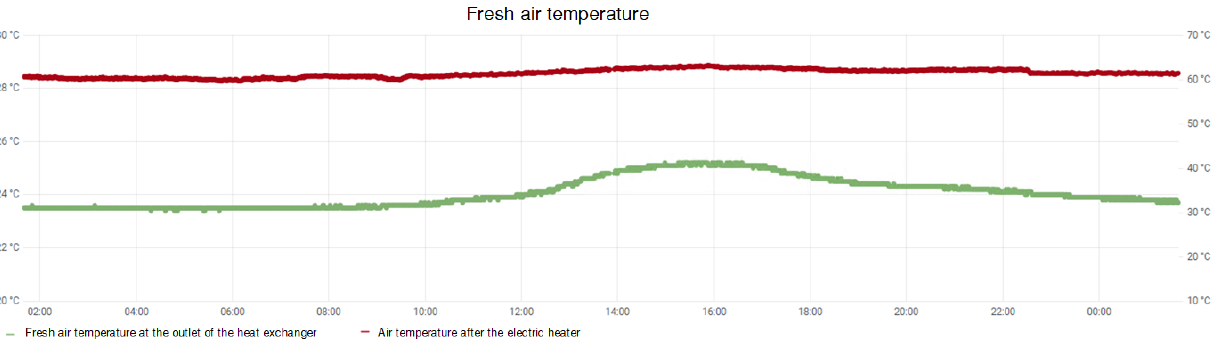
Figure 10. Fresh air temperature.